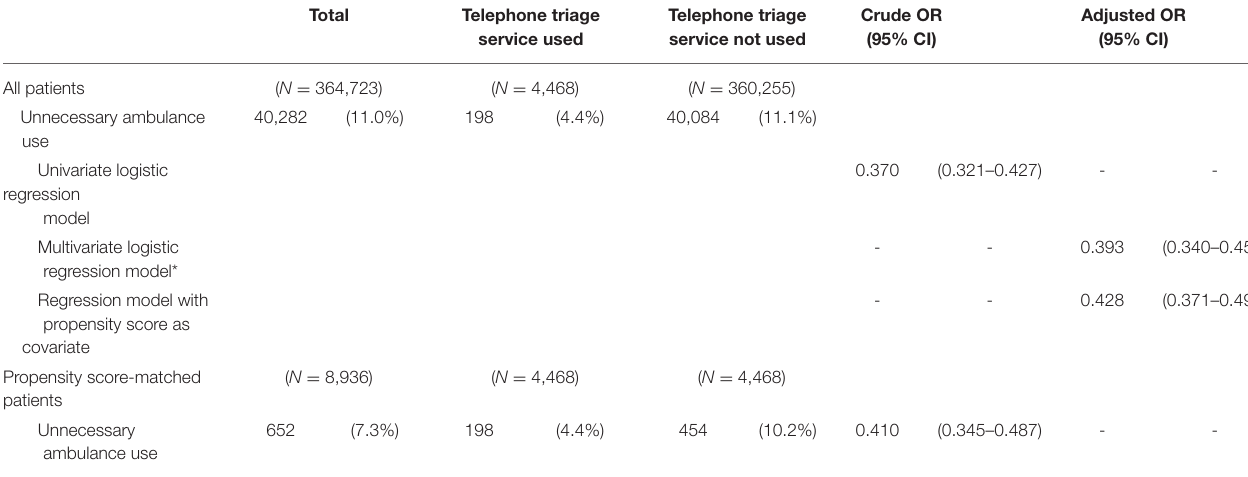
TABLE 4 | Unnecessary ambulance use with or without telephone triage service among adults. Total Telephone triage service